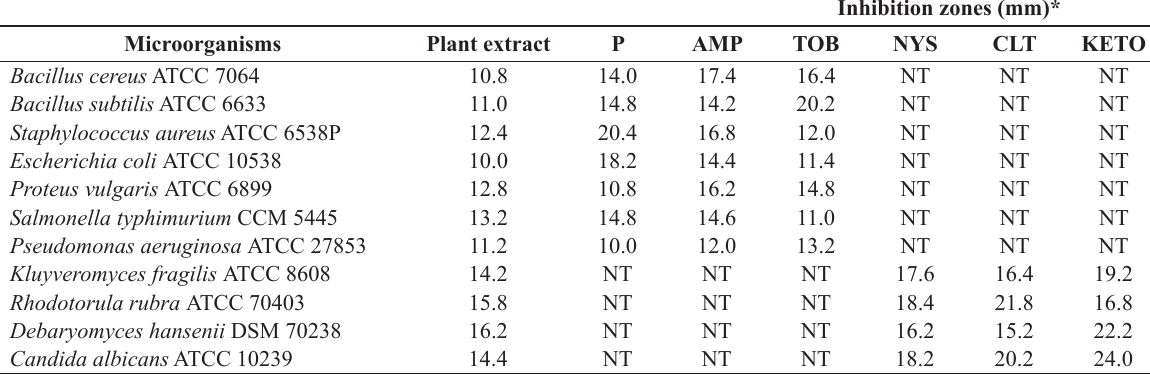
Disc diffusion results of Phlomis russeliana